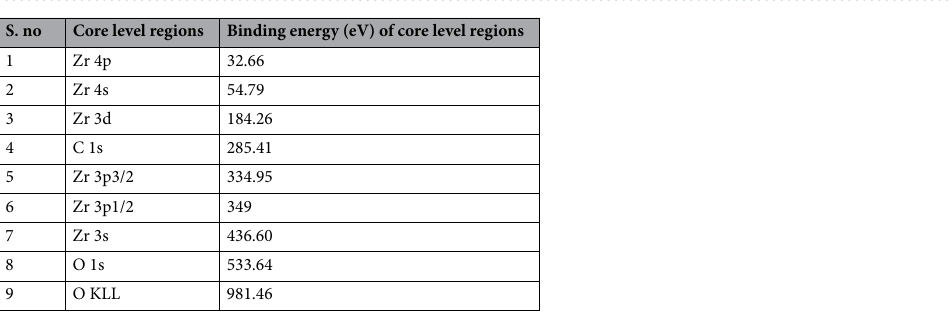
Table 2. Survey spectra of virgin and 2 × 10 14 ions/cm 2 determining the core level regions with their binding